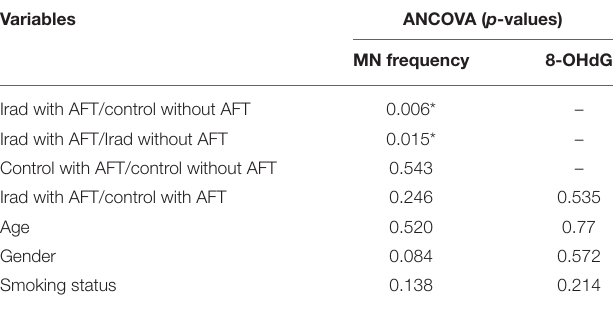
TABLE 2 | Multivariate analysis of the influence of age, gender, and smoking status on micronuclei and 8-OHdG.